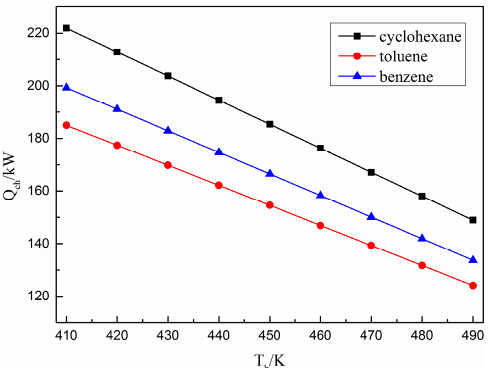
Figure 11. Effect of T b on cycle cooling load.